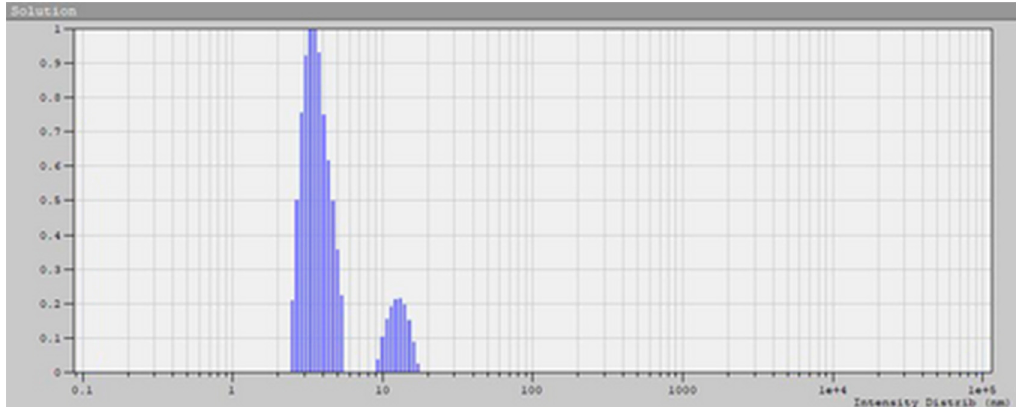
Figure 2. The distribution of light scattering intensity I on hydrodynamic radii R h-i of scattering species of CL-PiPrOx in 2-NP at concentration c = 0.0436 g · mL − 3 .